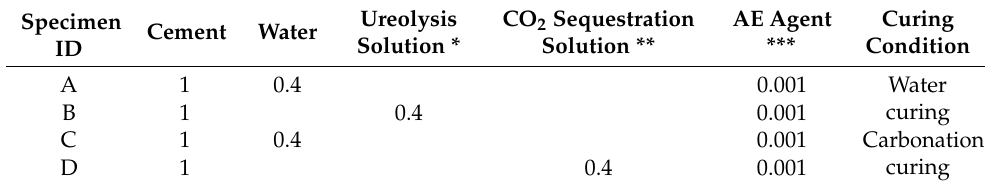
Table 1. Mix proportions of paste specimens by mass